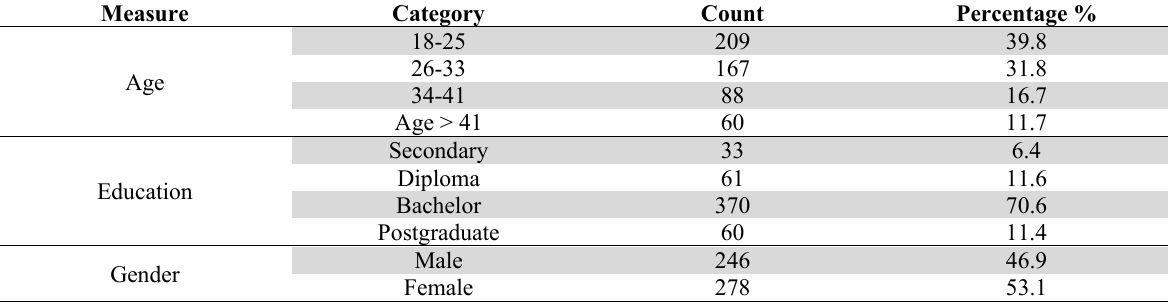
Sample Demographic